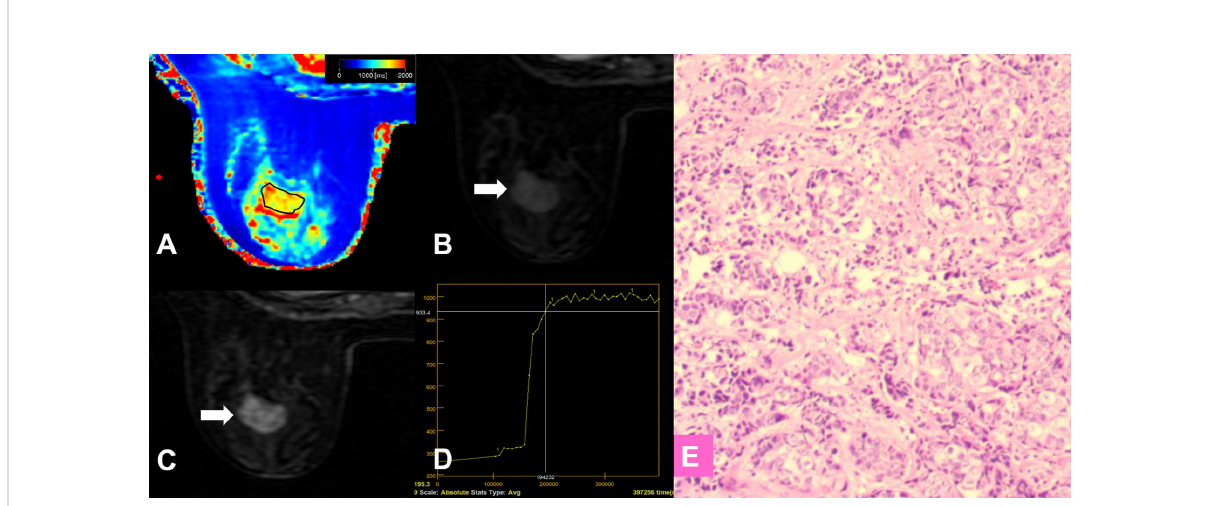
FIGURE 5 False-negative lesion identi fi ed by the KS. (A – E) A 56-year-old female patient: MRI showed a mass lesion in the left breast [ (B, C) , white arrow]. The lesion showed no root sign, circumscribed margins (B, C) , and a plateau enhancement curve type (D) . (A) T1 map, (B) Early contrast- enhanced MRI, (C) Delayed contrast-enhanced MRI, (D) TIC curve, (E) Pathological image (H&E, 100×). The Kaiser score was 2 and the lesion was classi fi ed as negative for malignancy. The T1 relaxation time was 1449.45 ms, which was lower than the cutoff value of 1595.94 ms. The combined diagnosis using the KS and T1 value identi fi ed malignancy. Histopathology revealed an invasive ductal carcinoma (E)